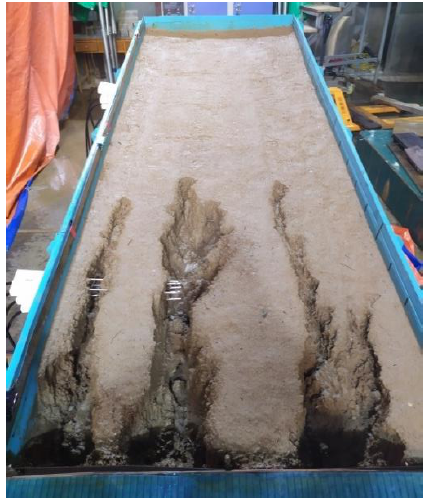
Figure 2. Field test photos.